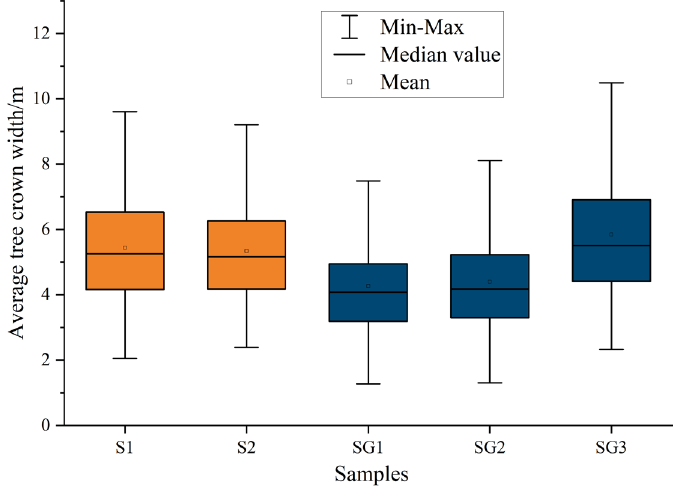
Figure 9. The average canopy width inside and outside the tiankeng. The orange and blue box plots represented the average canopy width values inside and outside the tiankengs, respectively.